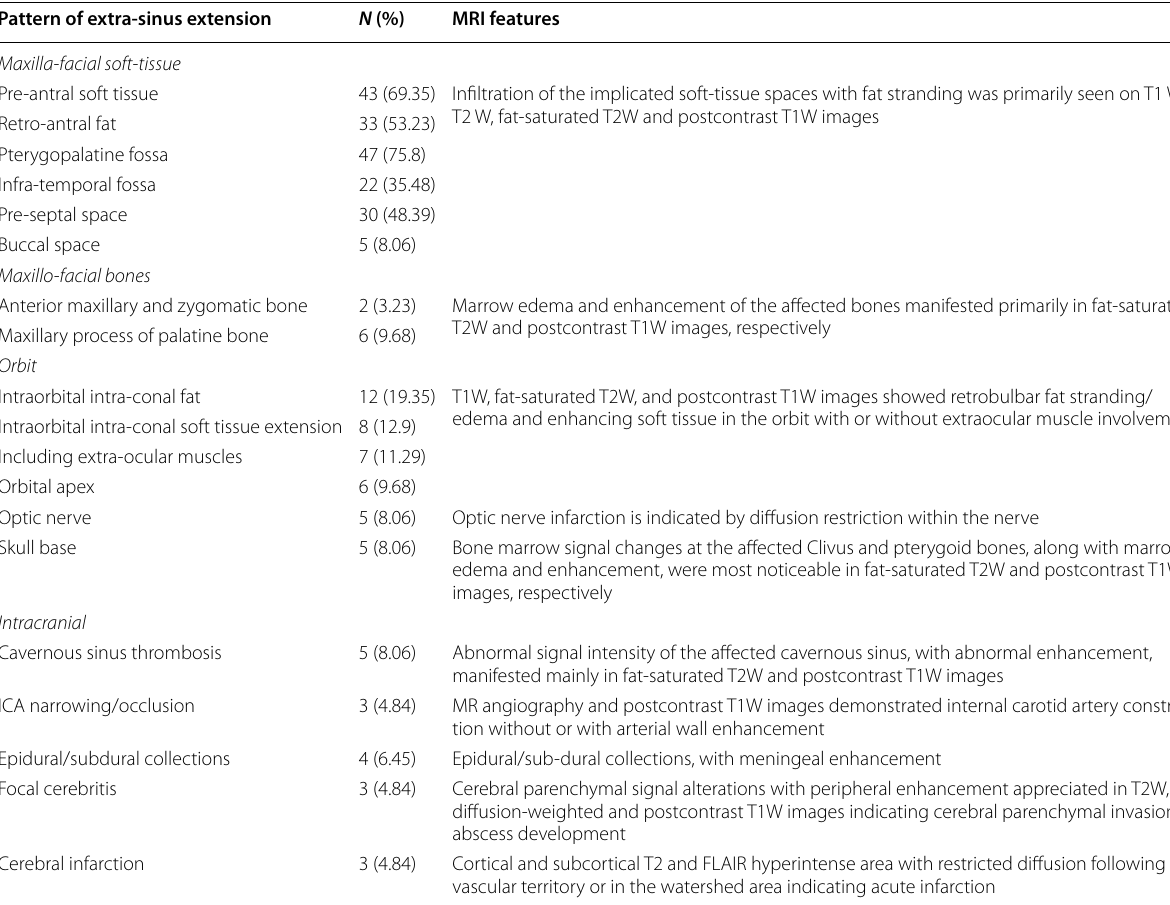
Table 6 MR imaging pattern for extra sinus extension Pattern of extra‑sinus extension N